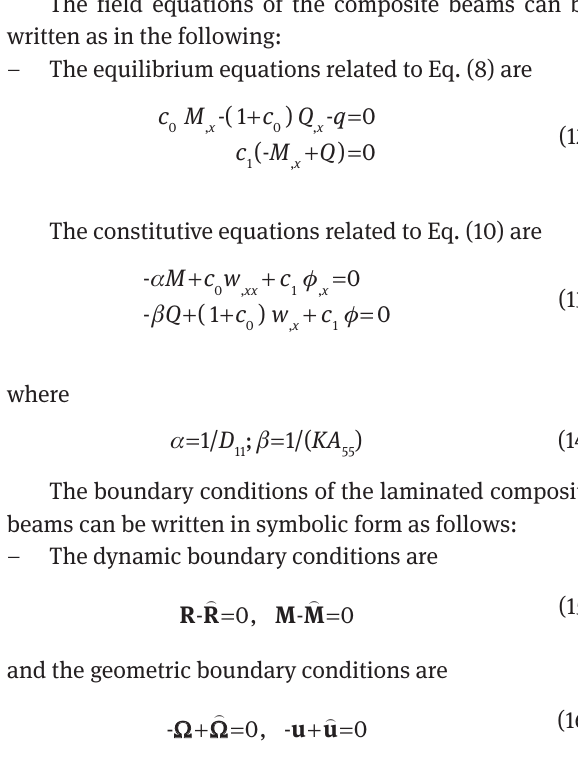
The parentheses with the subscripts σ and ε indicate the dynamic and geometric boundary conditions, respec- tively. And the terms with “ ∧ ” are valid if the boundary conditions are linear; otherwise, they